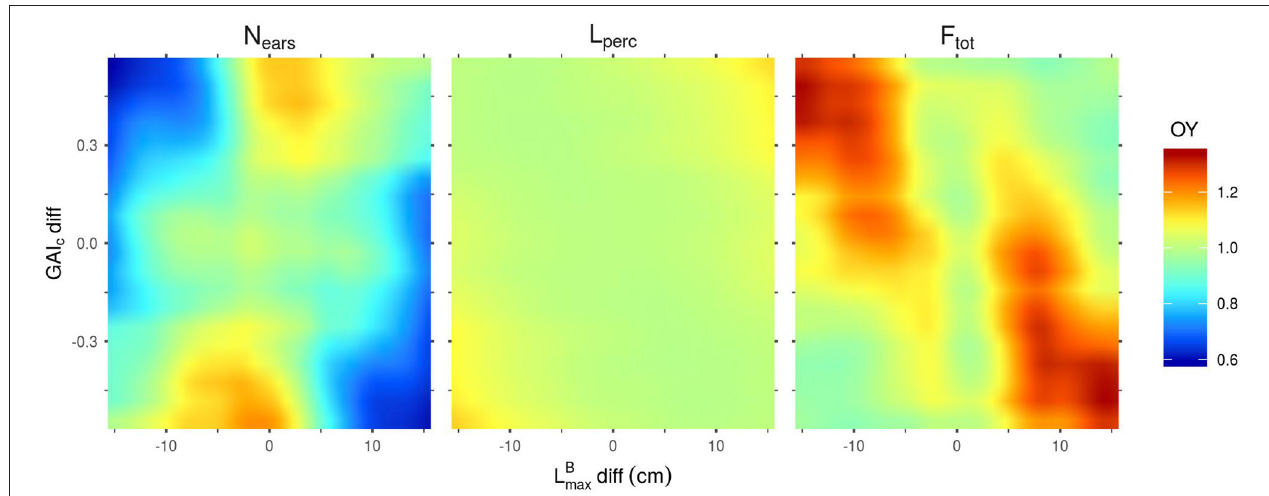
FIGURE 5 | Mean overyielding (OY) predicted by the Kriging metamodels for N ears , L perc and F tot as a function of GAI c -diff and L B max -diff. Predictions were made with all other parameters set to their mean values.